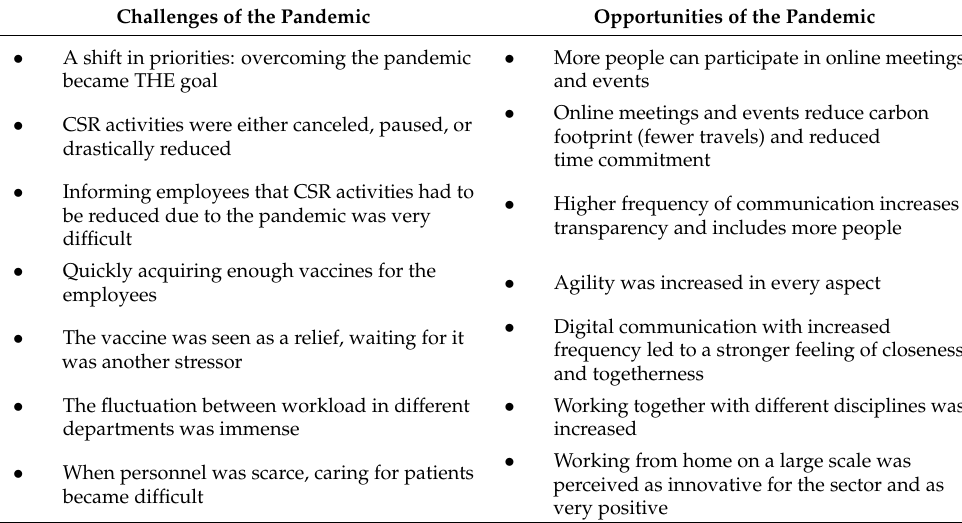
Table 5. Reported challenges and opportunities 1 of the